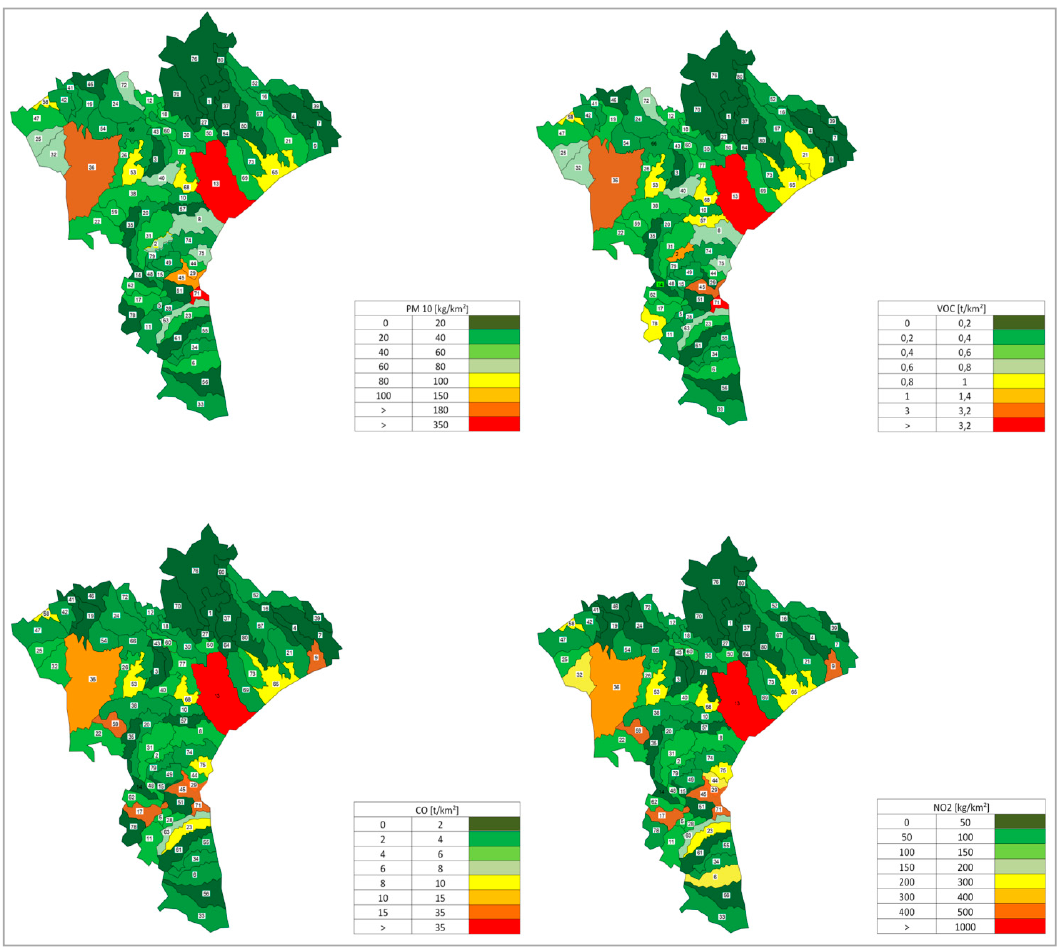
Figure 6. Choropleth maps of the eighty municipalities in the province of Catanzaro, relative to the production for area (Km 2 ), in 2015 of PM, VOC, CO, and NO 2.